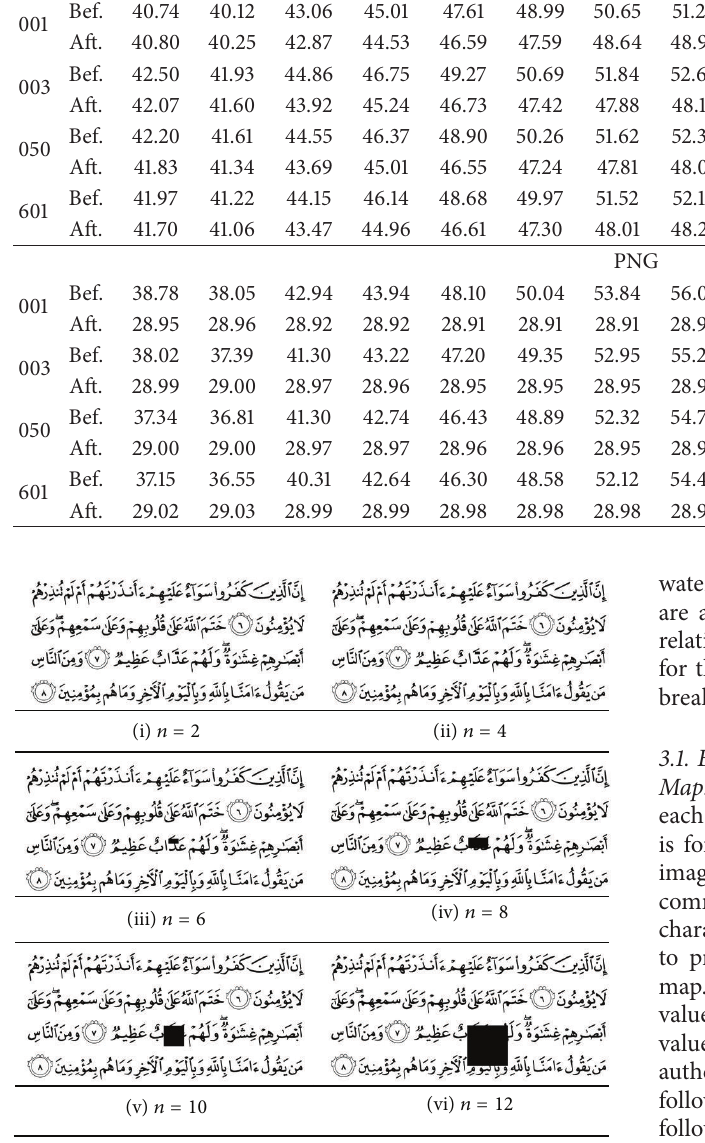
Figure 5: Tamper detection on pixel attack